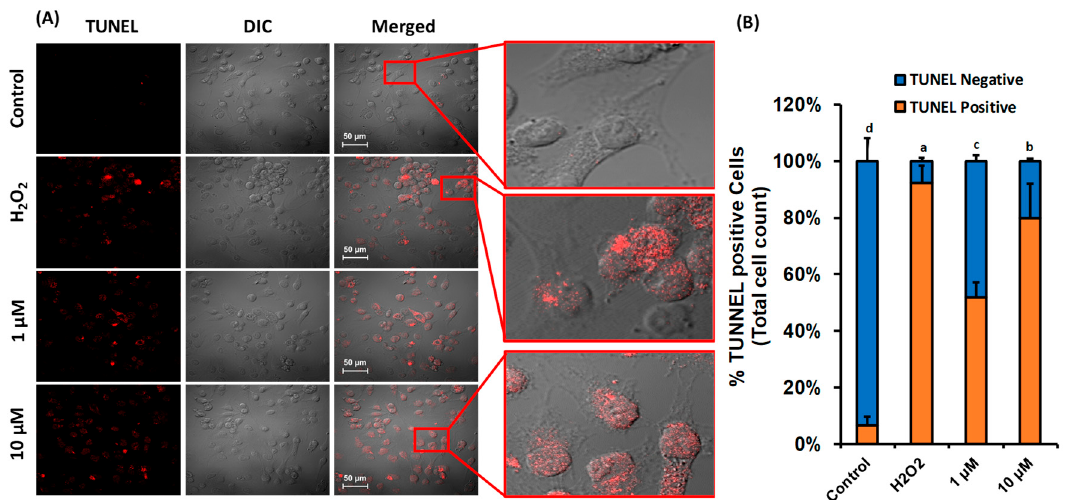
Figure 6. β -cryptoxanthin mediated HeLa cell nuclear DNA fragmentation detected by the TUNEL assay. ( A ) HeLa cells treated with β -cryptoxanthin (1.0 and 10 µM) for 24 h. The treatments with H 2 O 2 were used as a positive control to induce nuclear DNA fragmentation. Scale bar, 50 µm. ( B ) The percentage of TUNEL positive and negative cell counts. The TUNEL-positive cells were quantified by manual counting of at least 300 cells. All data are reported as mean values ± SD from independent experiments ( n = 3). The means accompanied by different alphabets (e.g., a, b, c, and d) are significantly different at p < 0.05. Scale bar, 50 µm.